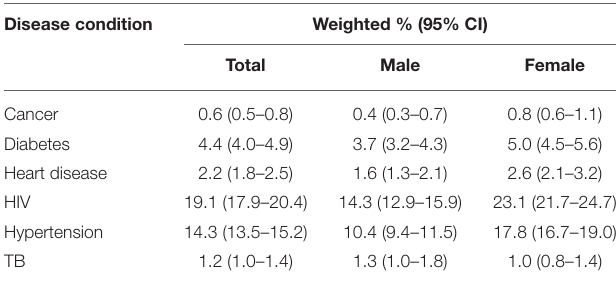
TABLE 2 | Estimated prevalence of single disease conditions (weighted). Disease condition